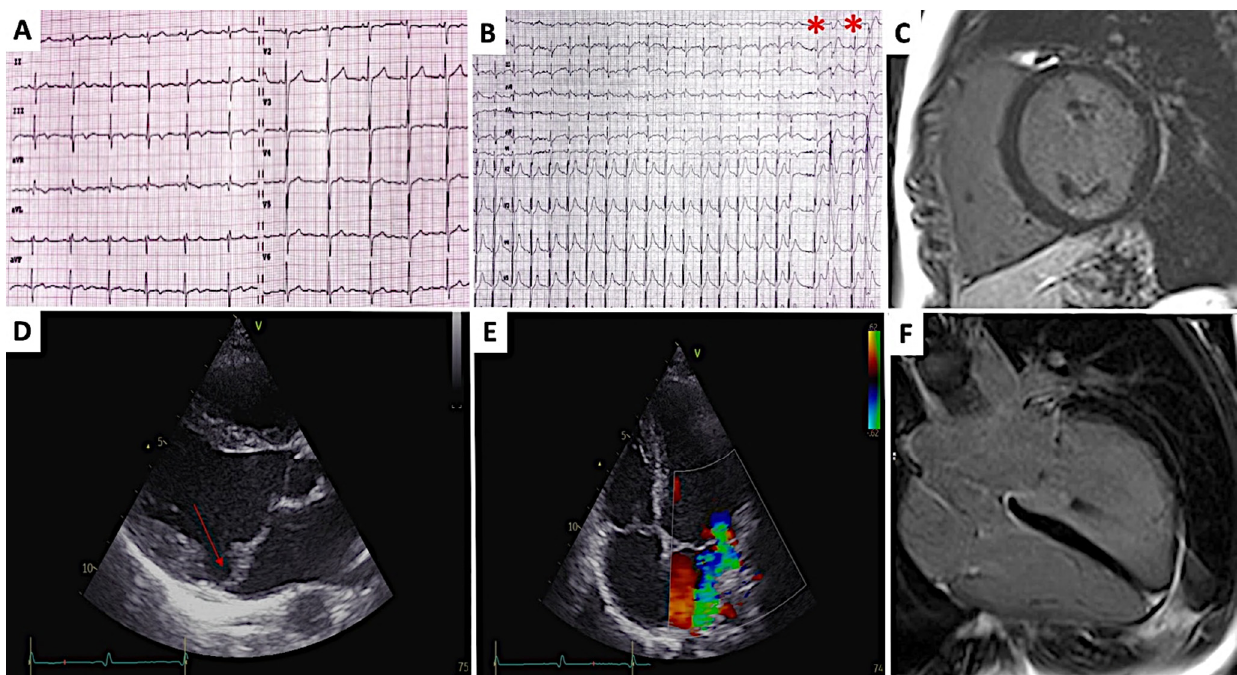
Figure 1. Male 11-year-old patient. ( A ). 12-leads ECG showing sinus rhythm, non-specific repolari- zation abnormalities on inferior leads (II, III, aVF). ( B ). 12-leads ECG recorded during the recovery phase of the treadmill test revealing premature ventricular contractions of right bundle branch block morphology (red asterisks). ( D ). 2D-echocardiogram in parasternal long axis view showing redun- dant and prolapsing mitral valve leaflets, MAD (red arrow) and mild dilatation of the left ventricle. ( E ). Apical 4-chamber view showing mitral valve regurgitation mitral and tricuspid valve prolapses. ( C , F ). Cardiac magnetic resonance imaging. Late post contrast long and short axis images showing no sign of myocardial hyperenhancement.